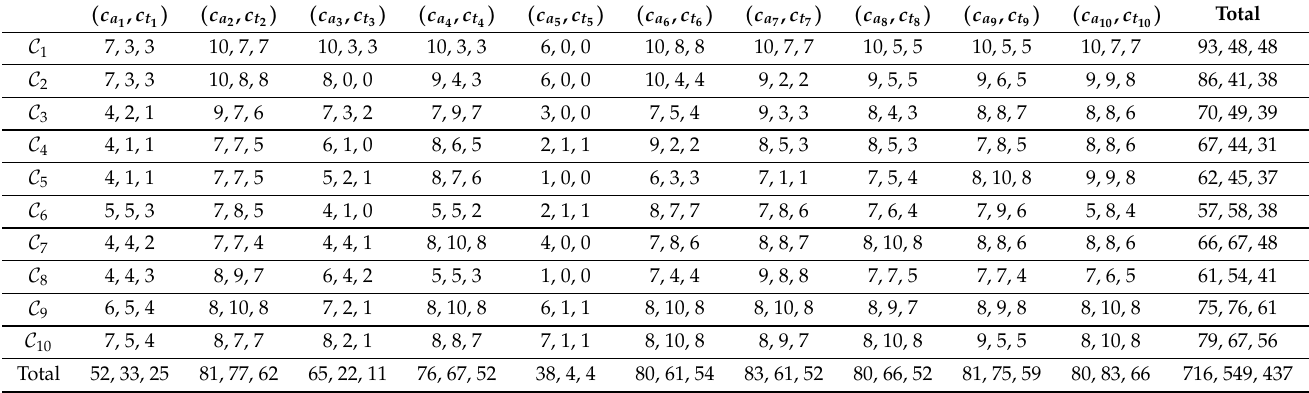
Figure A2. The 84 convenient ancestor images A p q used in the experiments, for which both the EA and BIM created 0.999-strong adversarial images D EA Table A1. For 1 ≤ k , q ≤ 10, the cell at the intersection of the row C k and column ( c a composed of a triplet α , β , γ , where α is the number of ancestors in c a 0.999-strong adversarial images, β is the number of ancestors in c a strong adversarial images, and γ is the number of common ancestors for which both algorithms terminated